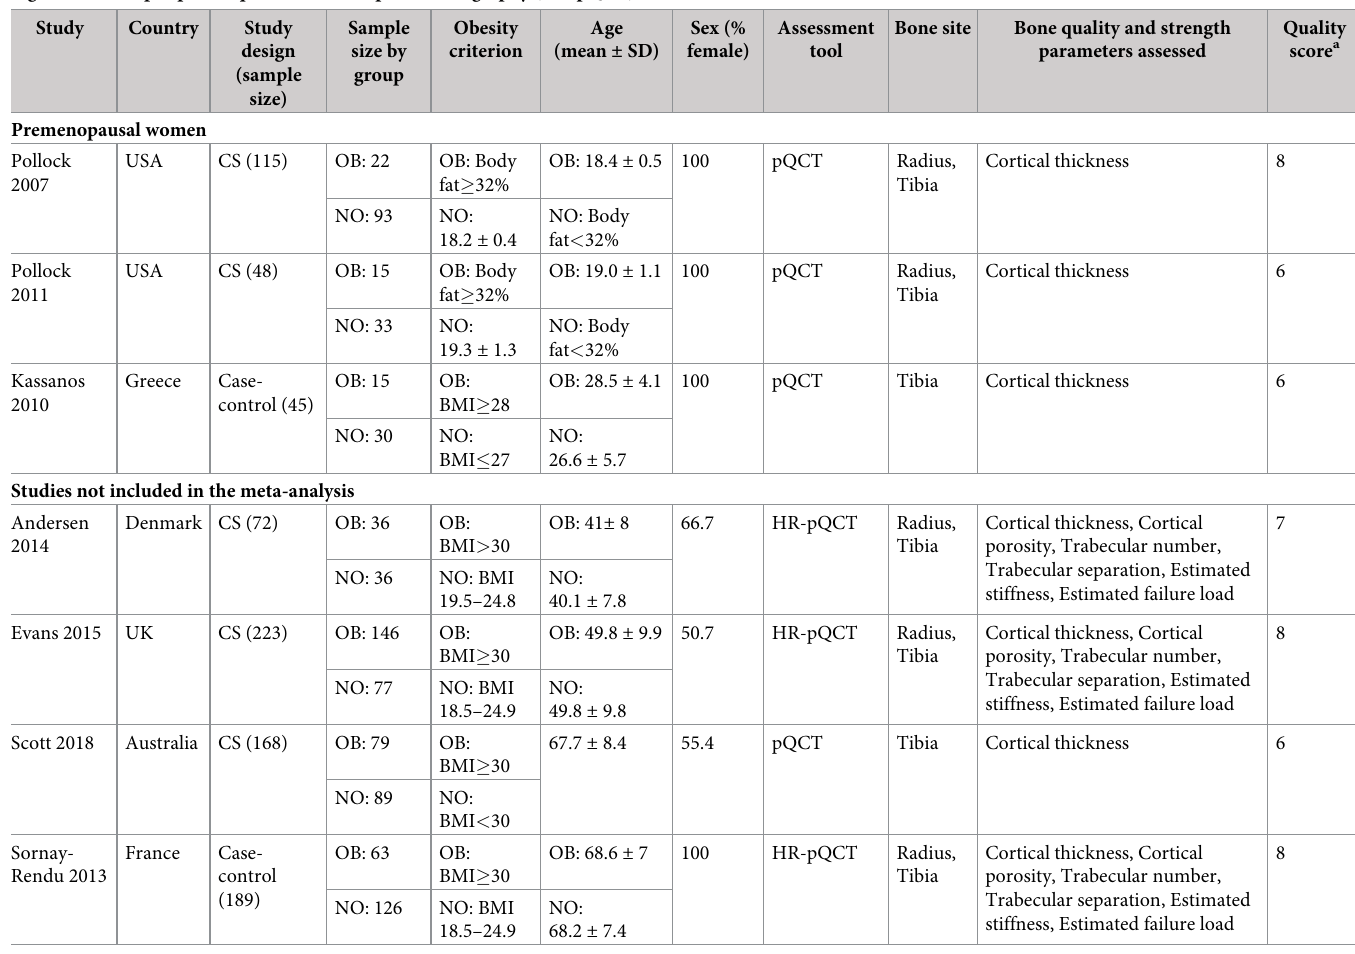
Table 3. Study and population characteristics of included studies for bone microarchitecture outcome by peripheral quantitative computed tomography (pQCT) or high-resolution peripheral quantitative computed tomography